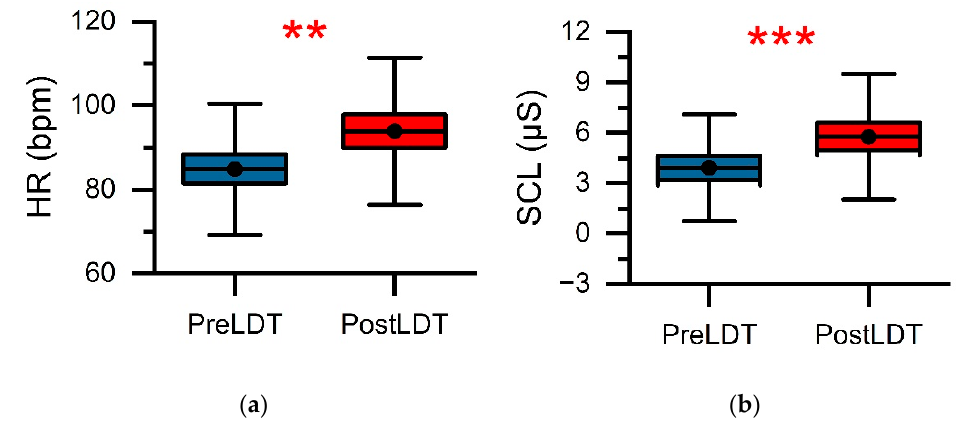
Figure 4. Mean values of ( a ) HR and ( b ) SCL for pre- and post-LDT. The error bars indicate the SD, and the red stars indicate significant differences (** p < 0.01 and *** p < 0.001). Table 2. The statistical results of physiological indexes (HR and SCL) for pre- and post-test of the LDT, RE, and DE.